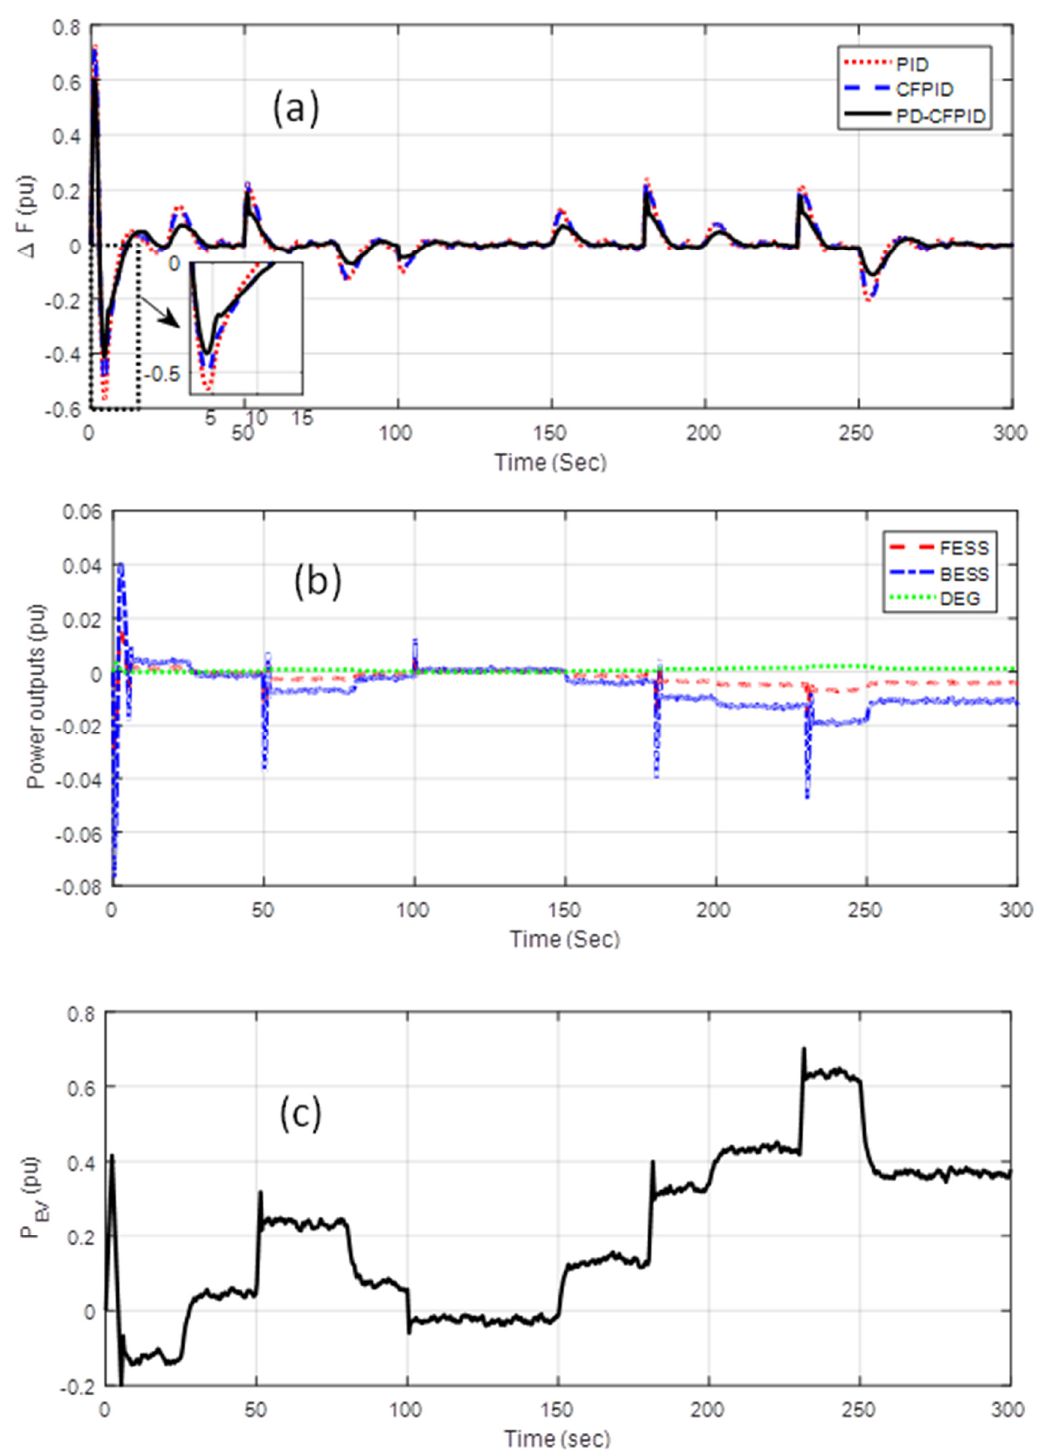
Figure 9. System response for case 1 ( a ) ∆ F. ( b ) P BESS , P FESS and P DEG . ( c ) P EV .